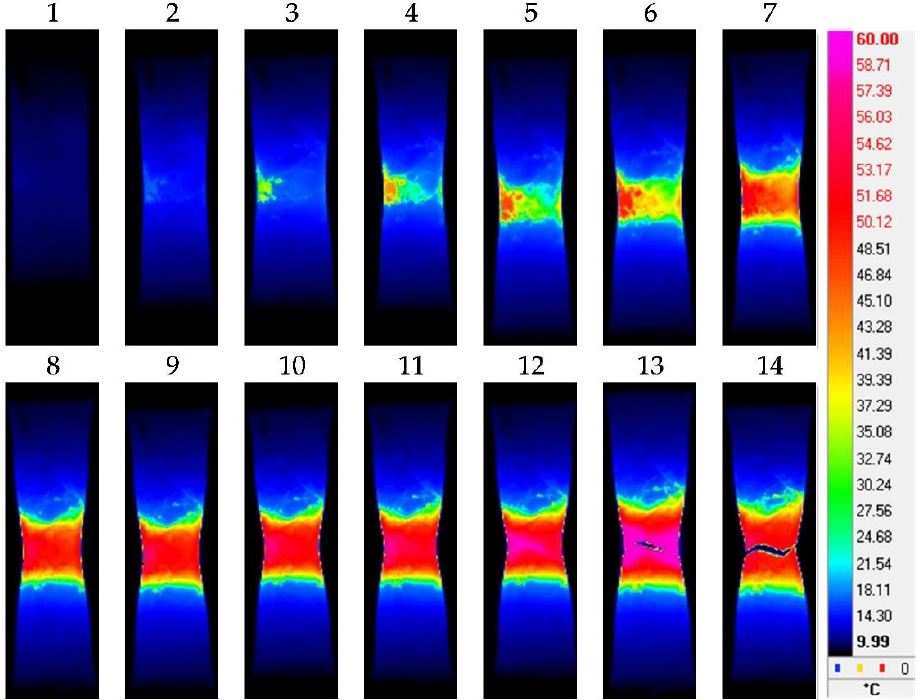
Figure 3. IR thermograms of deformed pure titanium sample in the CG state: 1 — ε = 0.1; 2 — ε = 0.11; 3 — ε = 0.12; 4 — ε = 0.125; 5 — ε = 0.14; 6 — ε = 0.155; 7 — ε = 0.17; 8 — ε = 0.18; 9 — ε = 0.19; 10 — ε = 0.205; 11 — ε = 0.215; 12 — ε = 0.225; 13 — ε = 0.235; 14 — ε = 0.24.